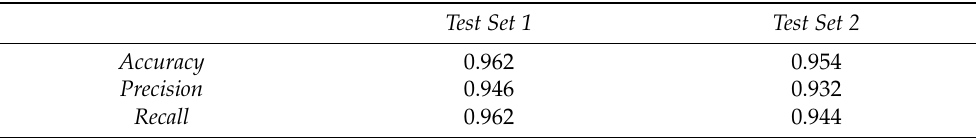
Table 1. Results of the CNN model’s prediction when compared with visual observation of the reference surface images.